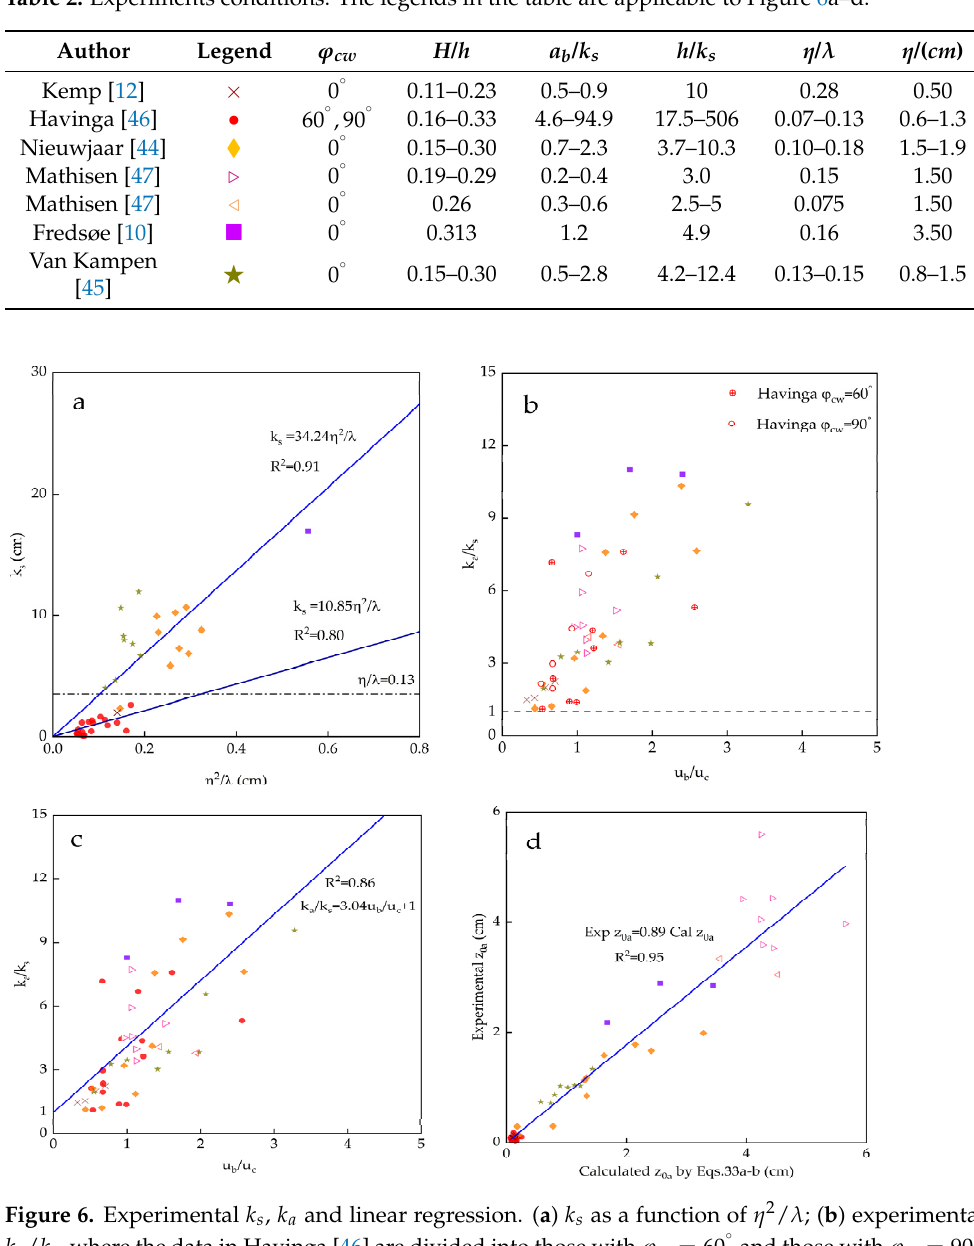
= 90 ° and those with φ = cw cw